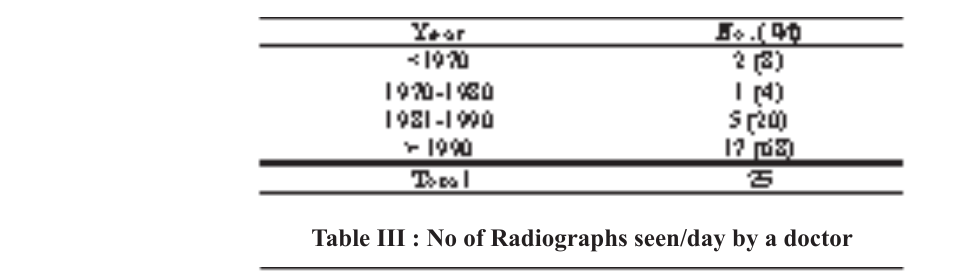
Table II : Year of passing MBBS